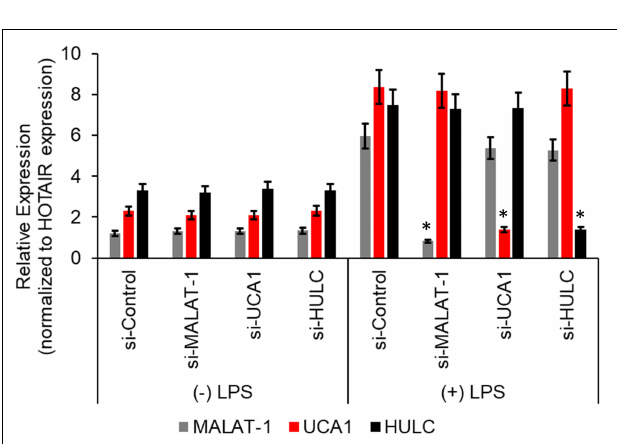
FIGURE 3 | Relative expression of HULC, UCA1, and MALAT-1 expression in ± LPS treated HMECs post-transfection with siRNAs targeting HULC, UCA1, and MALAT-1 or a scrambled control were performed by qRT-PCR. No difference in expression was noted in MALAT-1 (gray bars), UCA1 (red bars), or HULC (black bars) in the (–) LPS group following transfection of the siRNAs. In the (+) LPS group transfected with control scrambled siRNA expression was significantly higher for all three lncRNAs. Successful knockdown of the individual lncRNA following transfection of siRNA targeting that lncRNA was verified compared to the si-Control in (+) LPS group. Data represent mean ± standard deviation of three independent experiments, post-normalization to HOTAIR expression. ∗ P < 0.05, compared to control scramble siRNA transfected LPS treated HMECs.